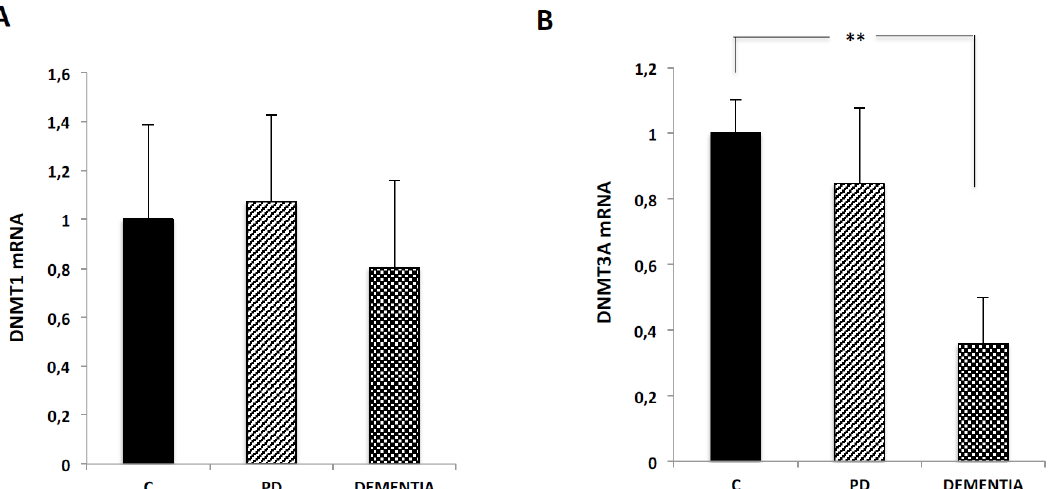
Figure 4. DNMT expression in blood samples from healthy subjects and patients with PD or dementia. Real time RT-qPCR in samples of the different groups with Taqman probes for DNMT1 ( A ) and DNMT3a ( B ). The study includes seven healthy subjects, 10 patients with PD and eight patients with different types of dementia. All data are means ± S.E.M. and are expressed relative to the values obtained in samples from healthy subjects. Significance of ANOVA and Bonferroni post-test among the indicated groups is shown as ** p < 0.01.